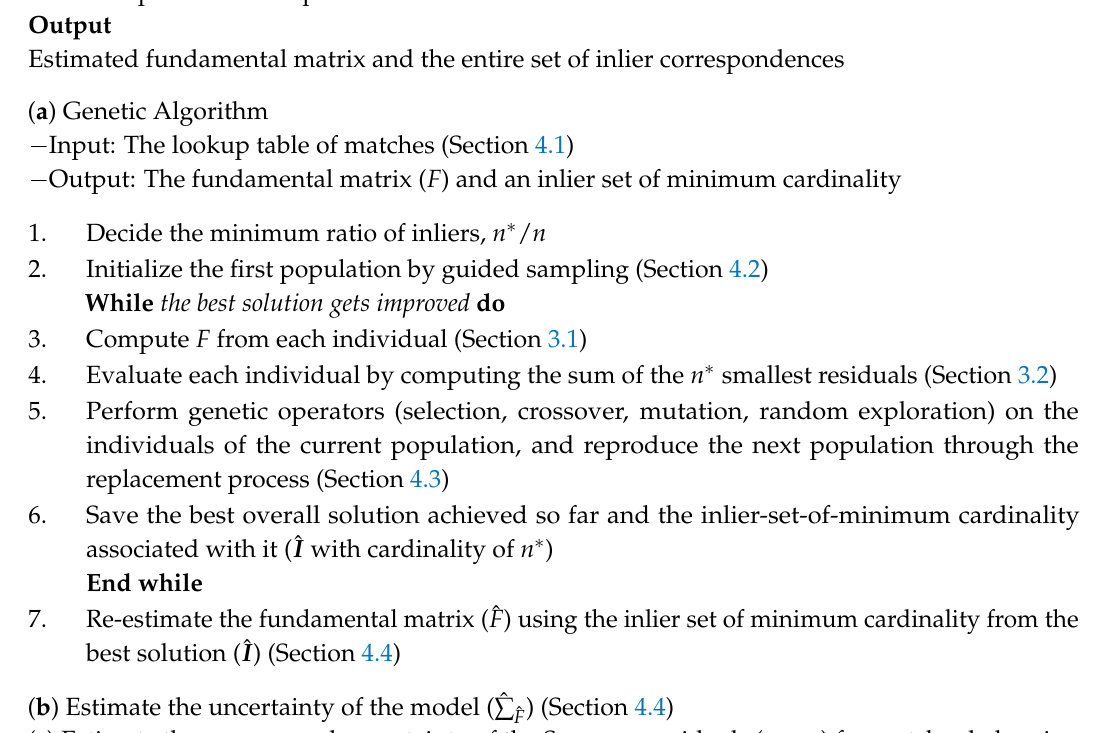
Algorithm 1: The proposed robust-estimation technique via the genetic